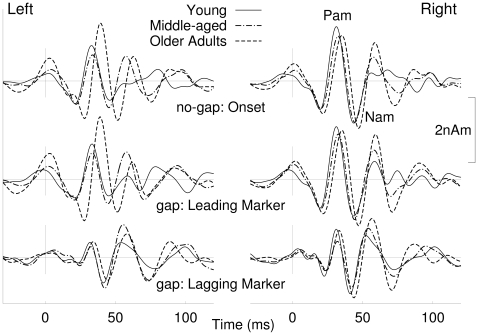
Overlay of grand averaged responses to the onset of no-gap stimuli for the three age groups (top traces).The most prominent positive and negative going waves are labeled in the right hemispheric responses as Pam and Nam according to the nomenclature used for middle latency responses. Grand averaged responses to the onset of the leading markers of gap stimuli are shown in the middle traces and responses to the lagging markers obtained from the difference waves in the bottom traces.